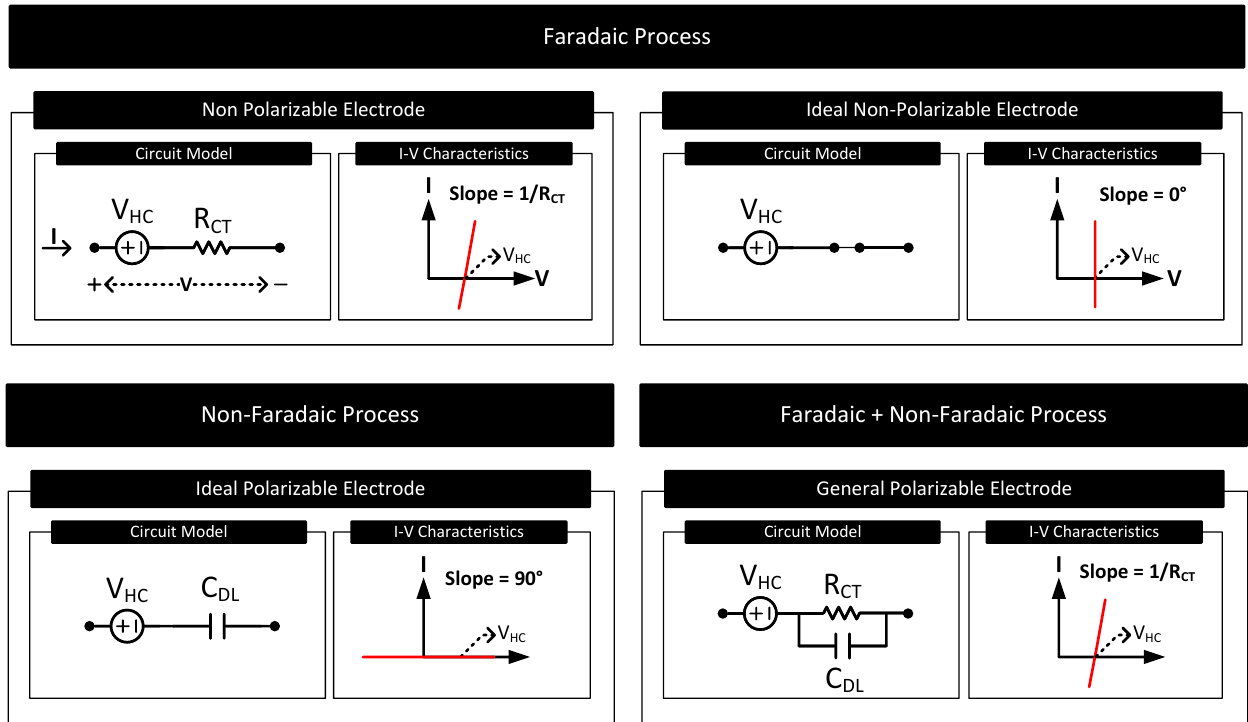
Figure 4. The circuit model and I-V characteristics of the electrode–electrolyte interface for electrodes of different polarization